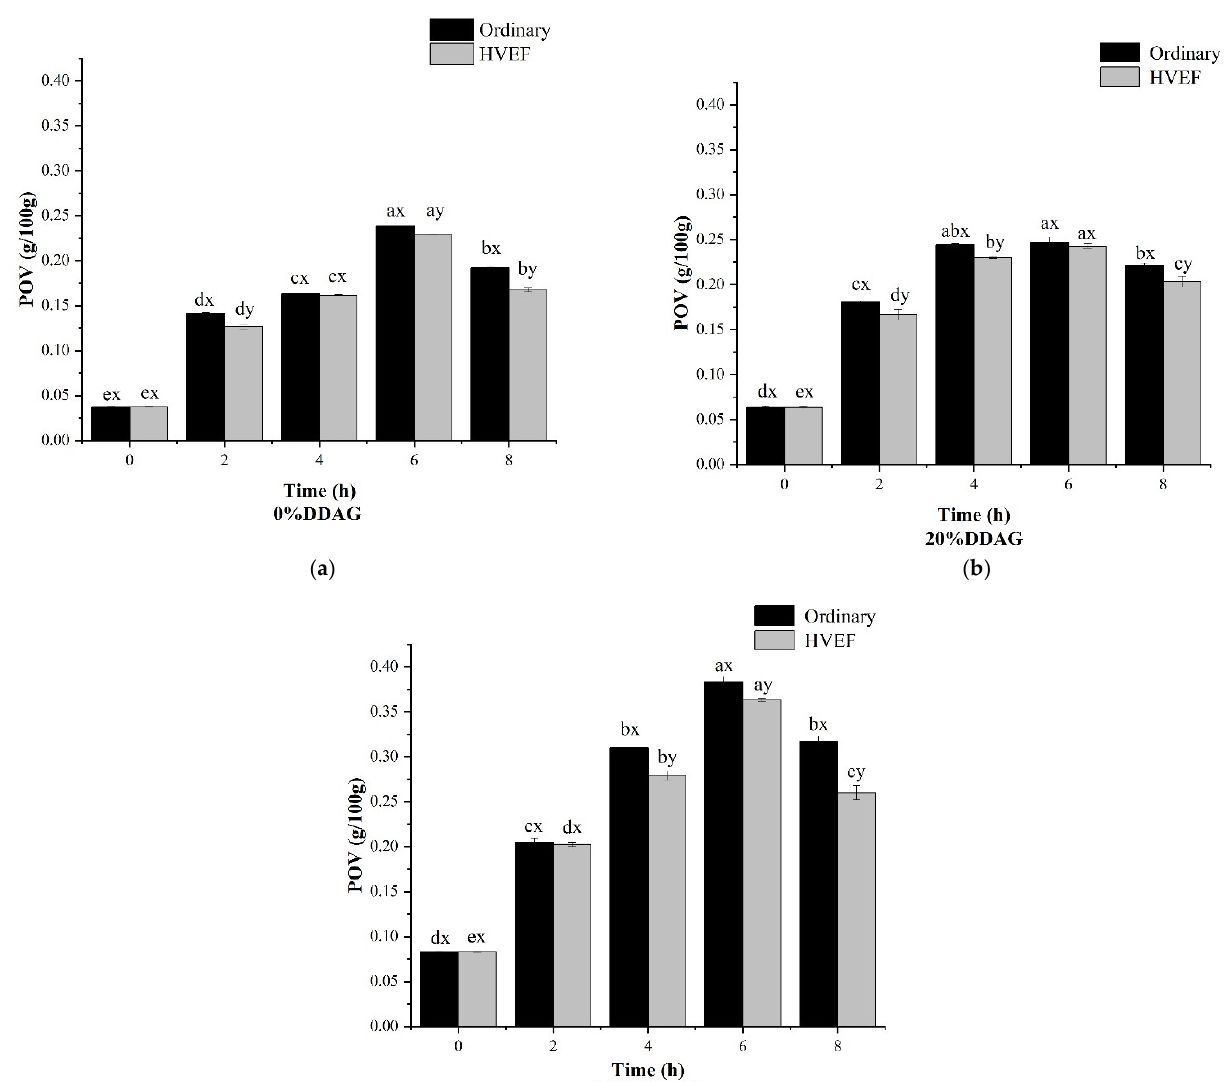
Figure 1. The POV of different DDAG concentrations of duck oils during ordinary heating and HVEF heating at 180 °C. ( a ) 0%DDAG; ( b ) 20%DDAG; ( c ) 100%DDAG. The letters a–e indicate significant differences ( p < 0.05) in the same color column at different heating times and the letters x and y indicate significant differences ( p < 0.05) at the same heating time between ordinary heating and HVEF heating.